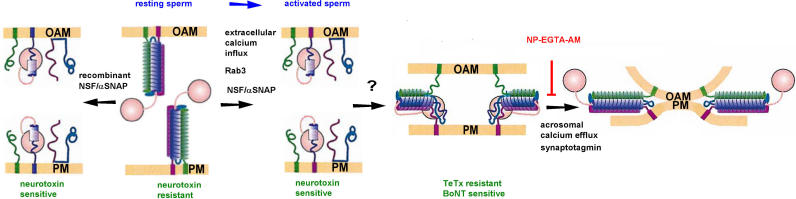
Working Model for the Dynamics of SNARE Assembly and Disassembly during AEThe resistance to neurotoxin proteolysis is indicated as determined experimentally here. The block by intra-acrosomal Ca2+ chelators is marked in red. OAM, outer acrosomal membrane; PM, plasma membrane. See text for more details (SNARE drawings were modified from [4]).